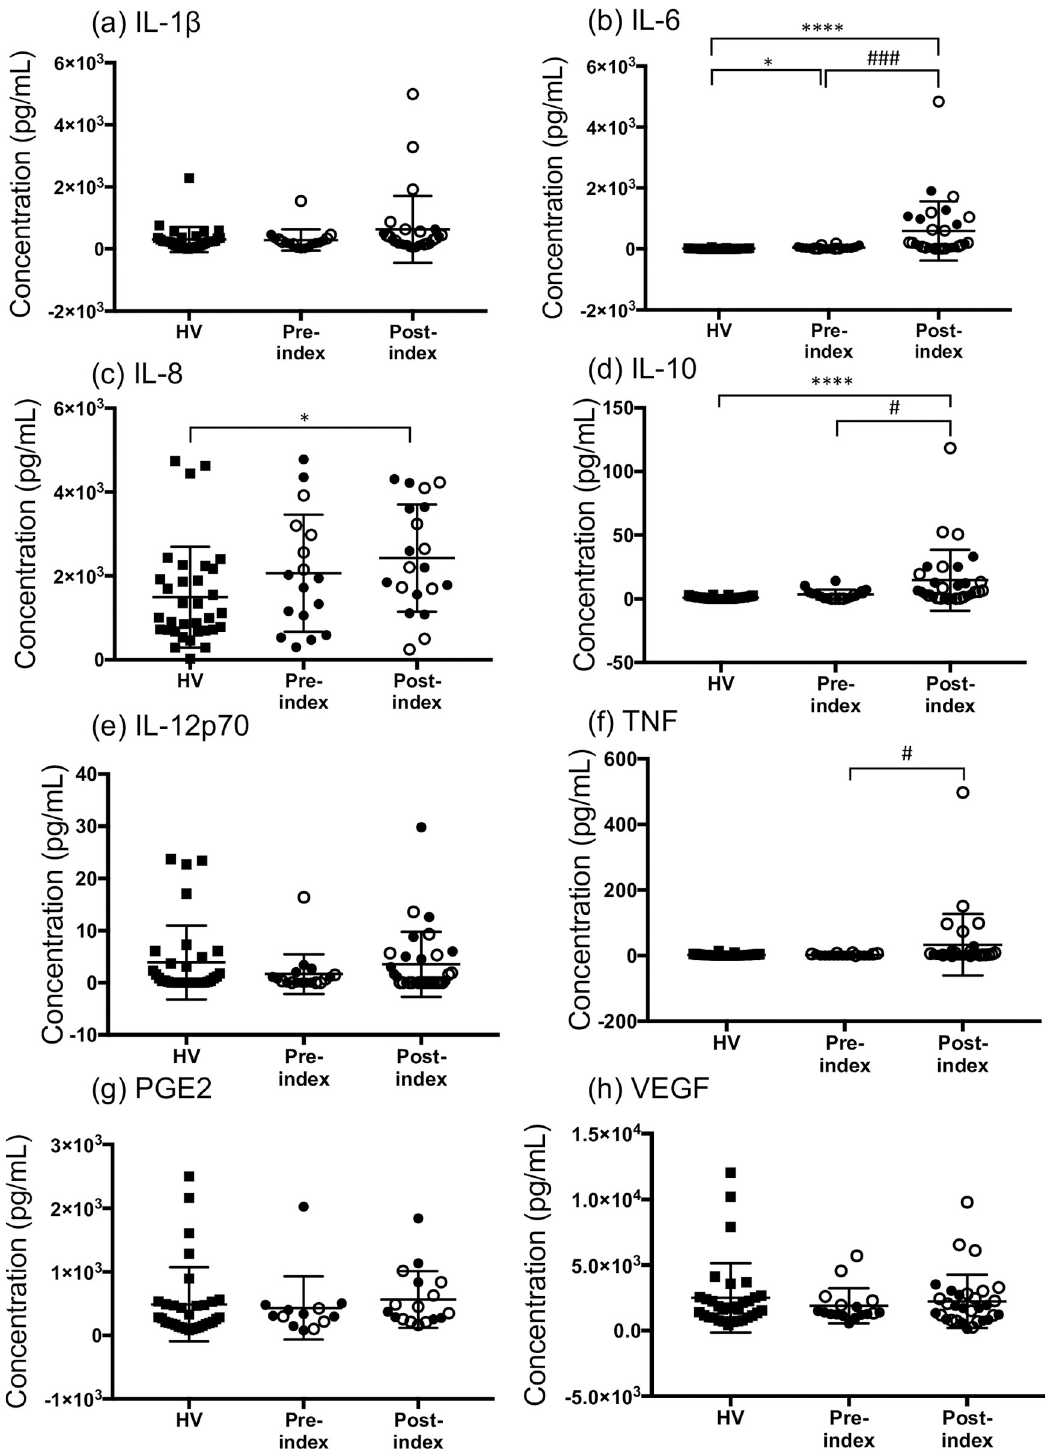
Fig 3. Concentration differences in salivary inflammatory mediators between healthy volunteers (HV) and pre- and post- index patients with cancer. (a) IL-1 β , (b) IL-6, (c) IL-8, (d) IL-10, (e) IL-12p70, (f) TNF, (g) PGE2, and (h) VEGF. Data are shown as mean ± standard deviation. The closed circles for the index groups represent patients with leukemia, while the open circles represent patients with head and neck carcinoma. All data for the post-index group were obtained at sampling points 2, 3, and 4, as described in the methods section. The data in the pre-index group (IL-1 β and VEGF; n = 1 and PGE2; n = 5) and the